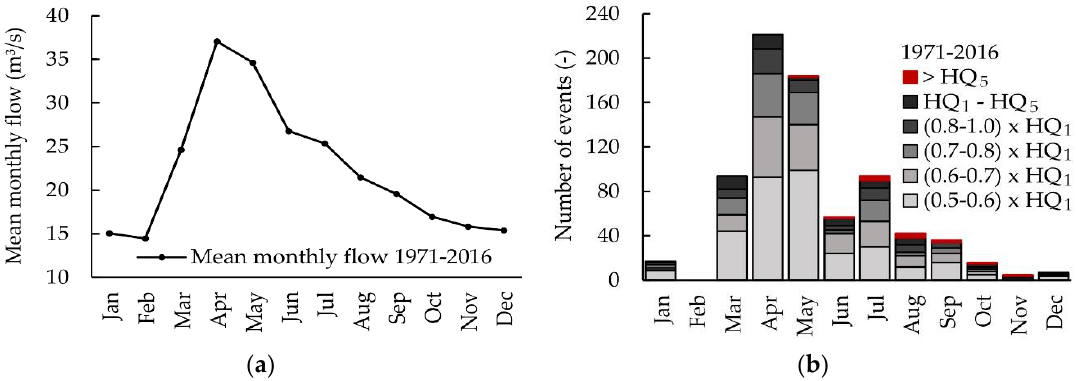
Figure 3. Comparison of hydrological data from the Kapfenberg for the years 1971–2016, ( a ) mean monthly flow; ( b ) frequency distribution for different flood events. Hydrograph data retrieved from www.ehyd.gv.at on 10 March 2019.